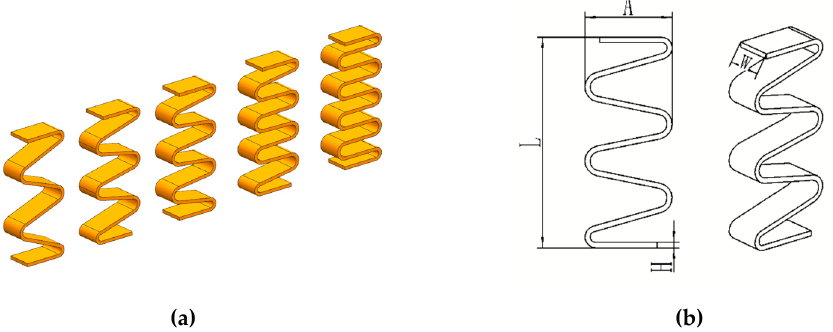
Figure 1. Structural diagram of GFRP wave springs. ( a ) The five different specimens, ( b ) Schematic diagram of the structure of the